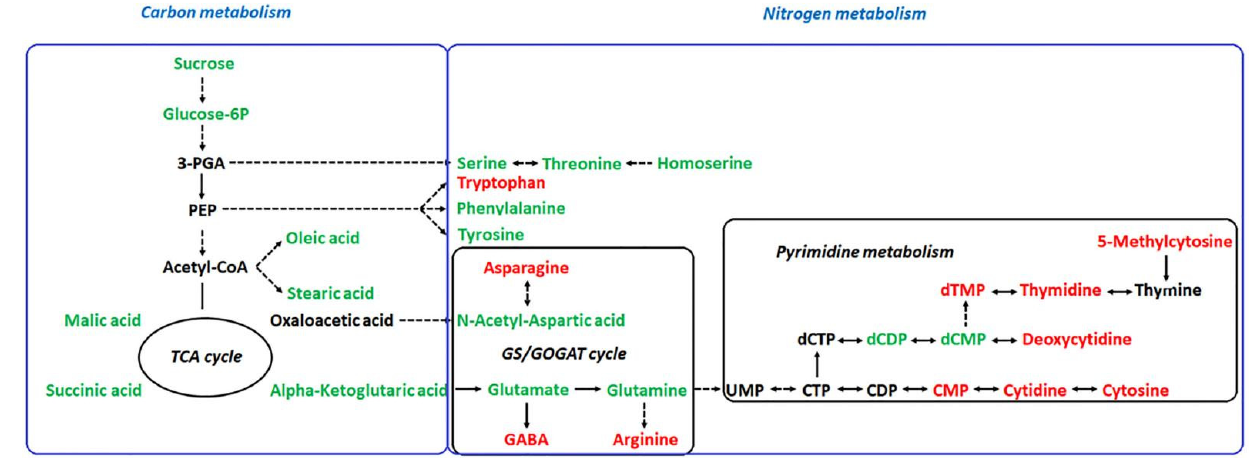
Figure 4. Changes in metabolic pathways of L. chinensis seedlings responding to alkali stress. Red ‐ marked metabolites indicated that the metabolite concentration increased significantly under alkali stress ( p < 0.05). Green ‐ marked metabolites indicated that the metabolite concentration decreased significantly under alkali stress ( p < 0.05). Black ‐ marked metabolites showed no significant change.